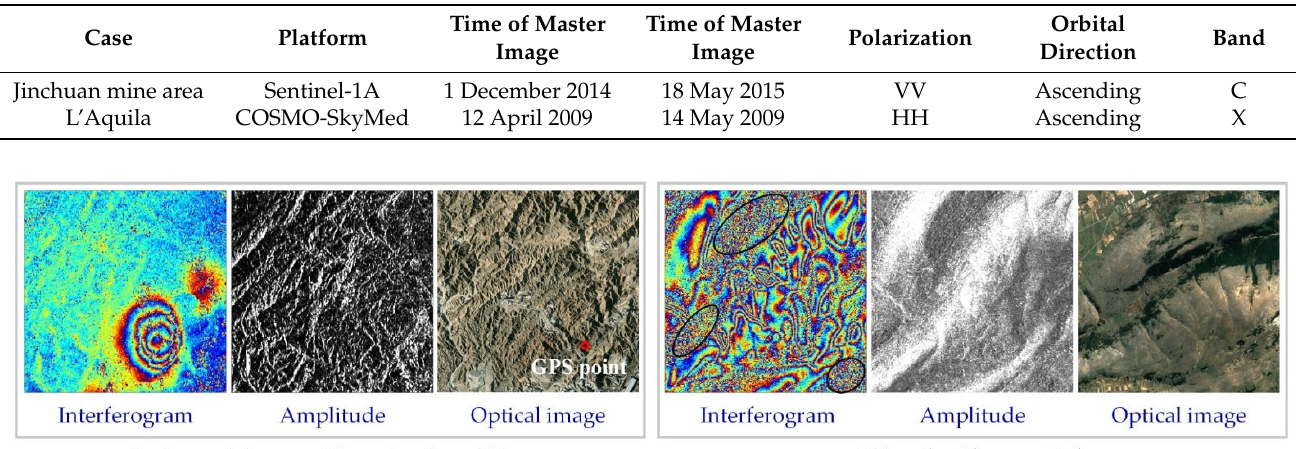
Table 2. Parameters of the real data.